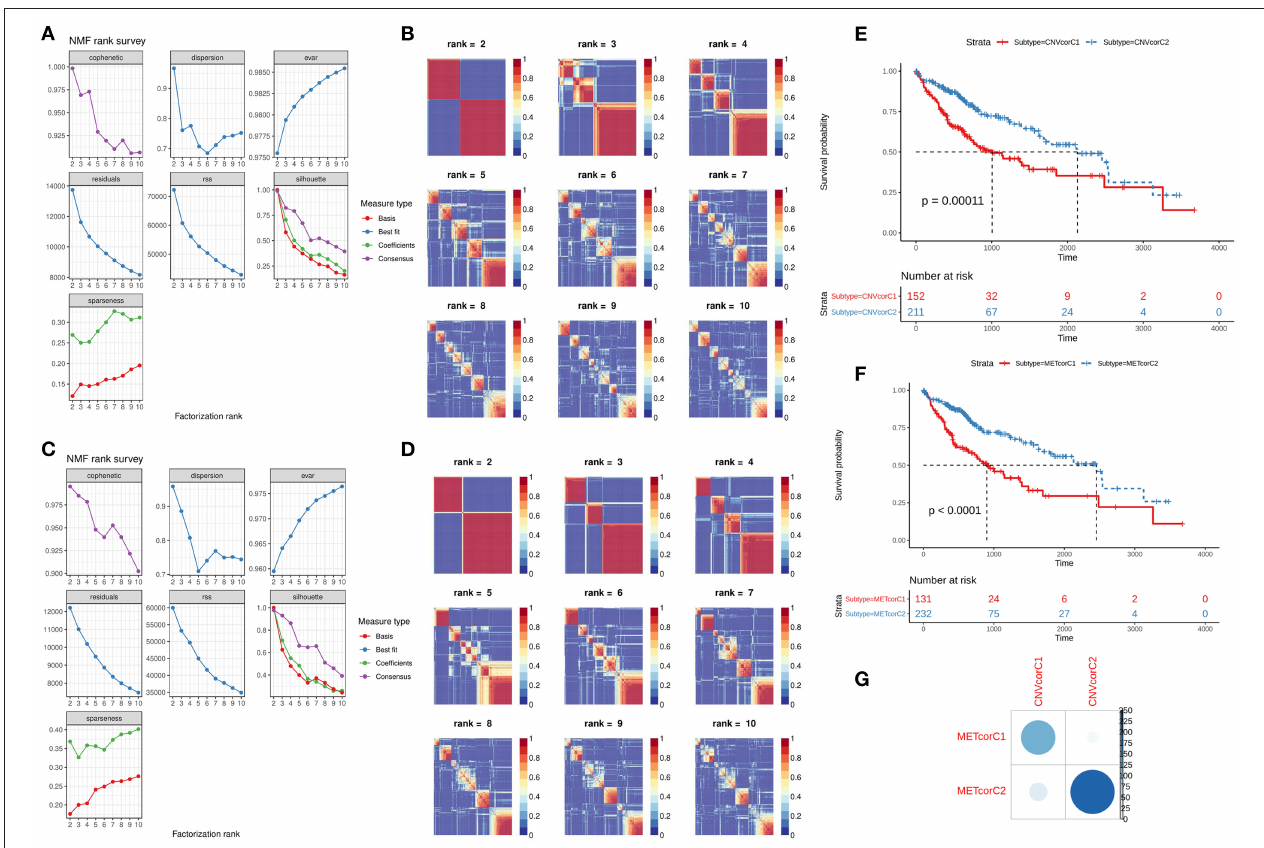
FIGURE 3 | Identification of molecular subtypes according to CNVcor and METcor genes. (A,B) NMF cluster analysis based on CNVcor genes. (C,D) NMF cluster analysis based on METcor genes. Kaplan-Meier curve analysis of CNVcor gene clusters (E) and METcor gene clusters (F) . (G) Overlap between CNVcor and METcor gene clusters. The color shade indicates the number of overlapping